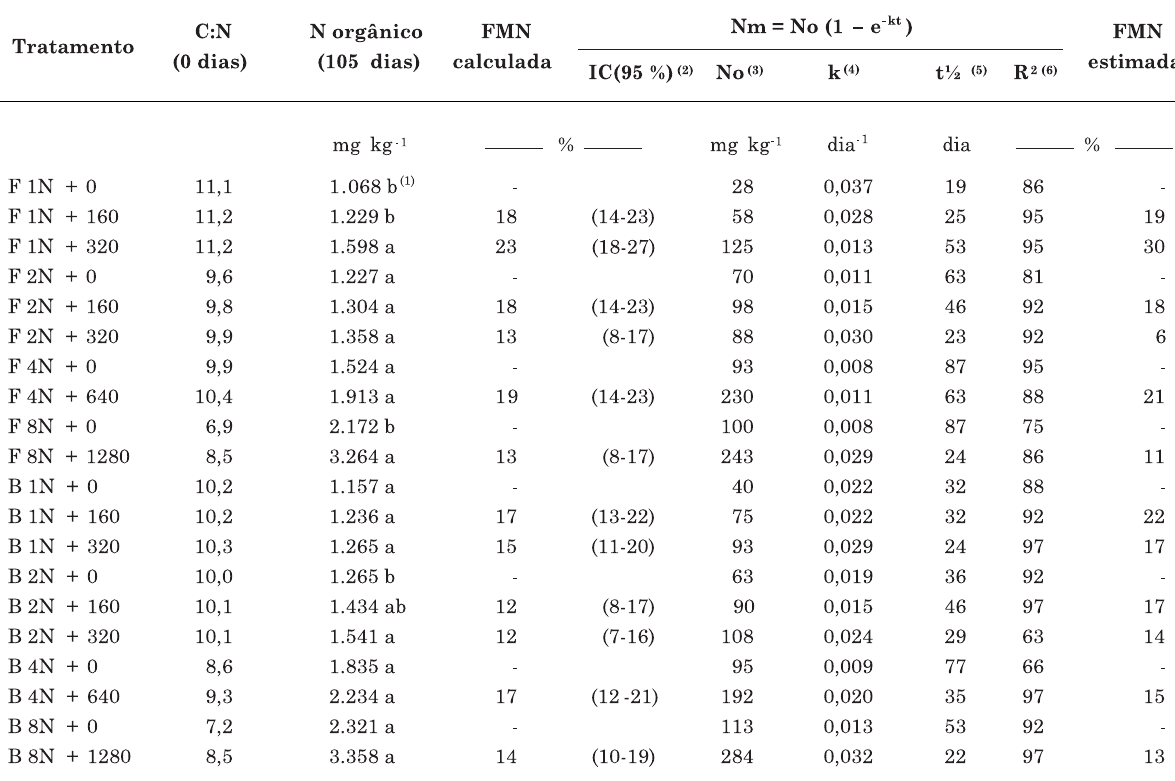
Quadro 4. Relação C:N, N orgânico, fração de mineralização de N orgânico (FMN) calculada para os lodo